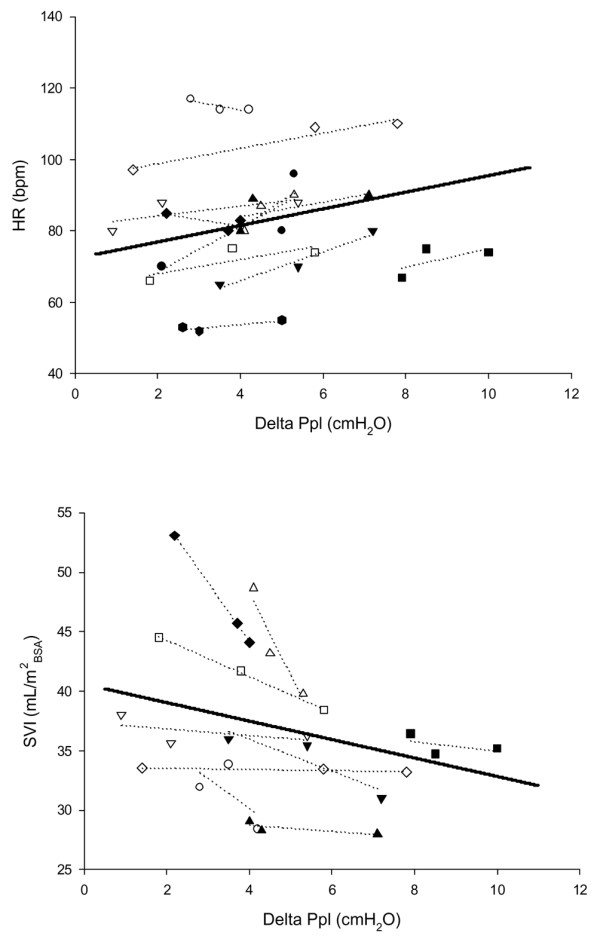
Intrathoracic pressure and hemodynamics. Top panel, association between pleural pressure change (delta Ppl) and heart rate (HR); bottom panel, association between pleural pressure change and stroke volume index (SVI). Each patient is represented with a different symbol and the values recorded in the three different conditions are all indicated, together with the regression line about these points for each individual patient. A regression line for the whole model of association is also depicted (thick line). Pleural pressure change is significantly associated with heart rate (p = 0.0003) and with stroke volume index (p = 0.0241).